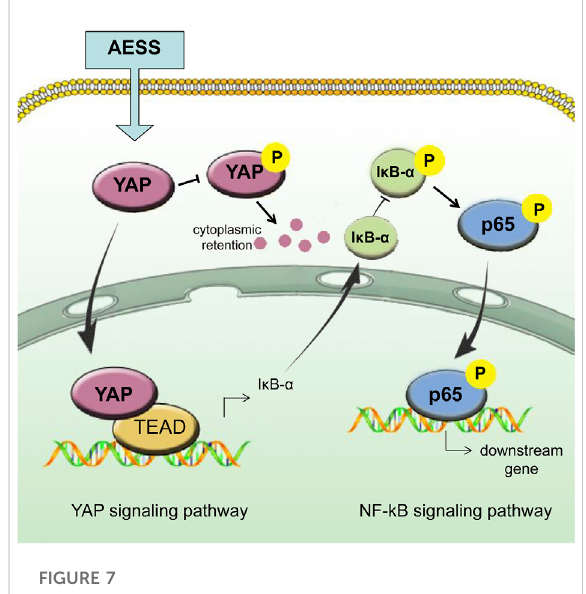
FIGURE 7 Schematic of AESS ’ s effect on AD trough the intereaction of YAP and NF- κ B signaling